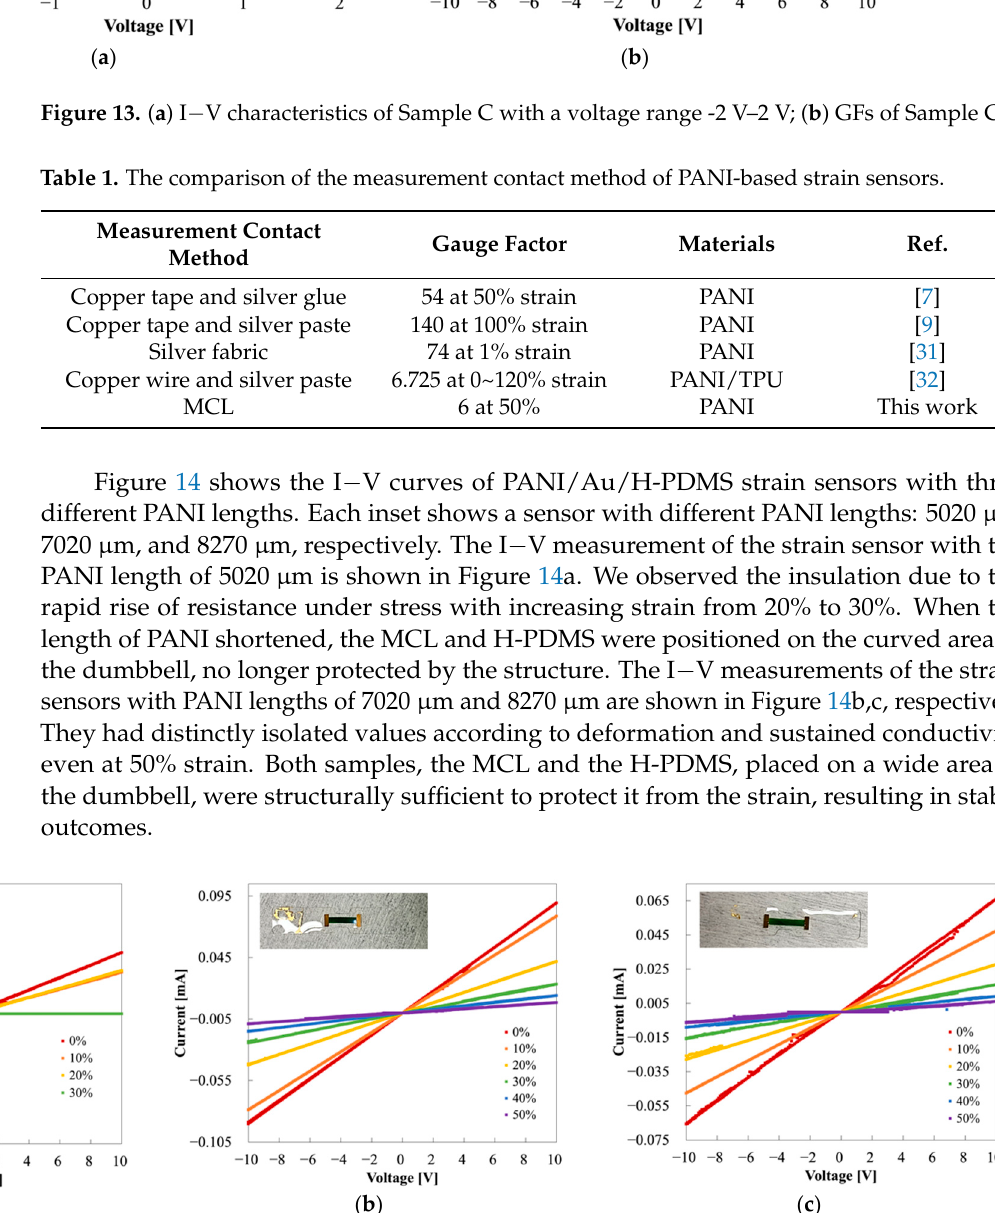
Figure 14. I − V curves of the PANI/Au/H-PDMS strain sensor according to the different lengths of PANI: ( a ) 5020 μm , ( b ) 7020 μm , and ( c ) 8270 μm .